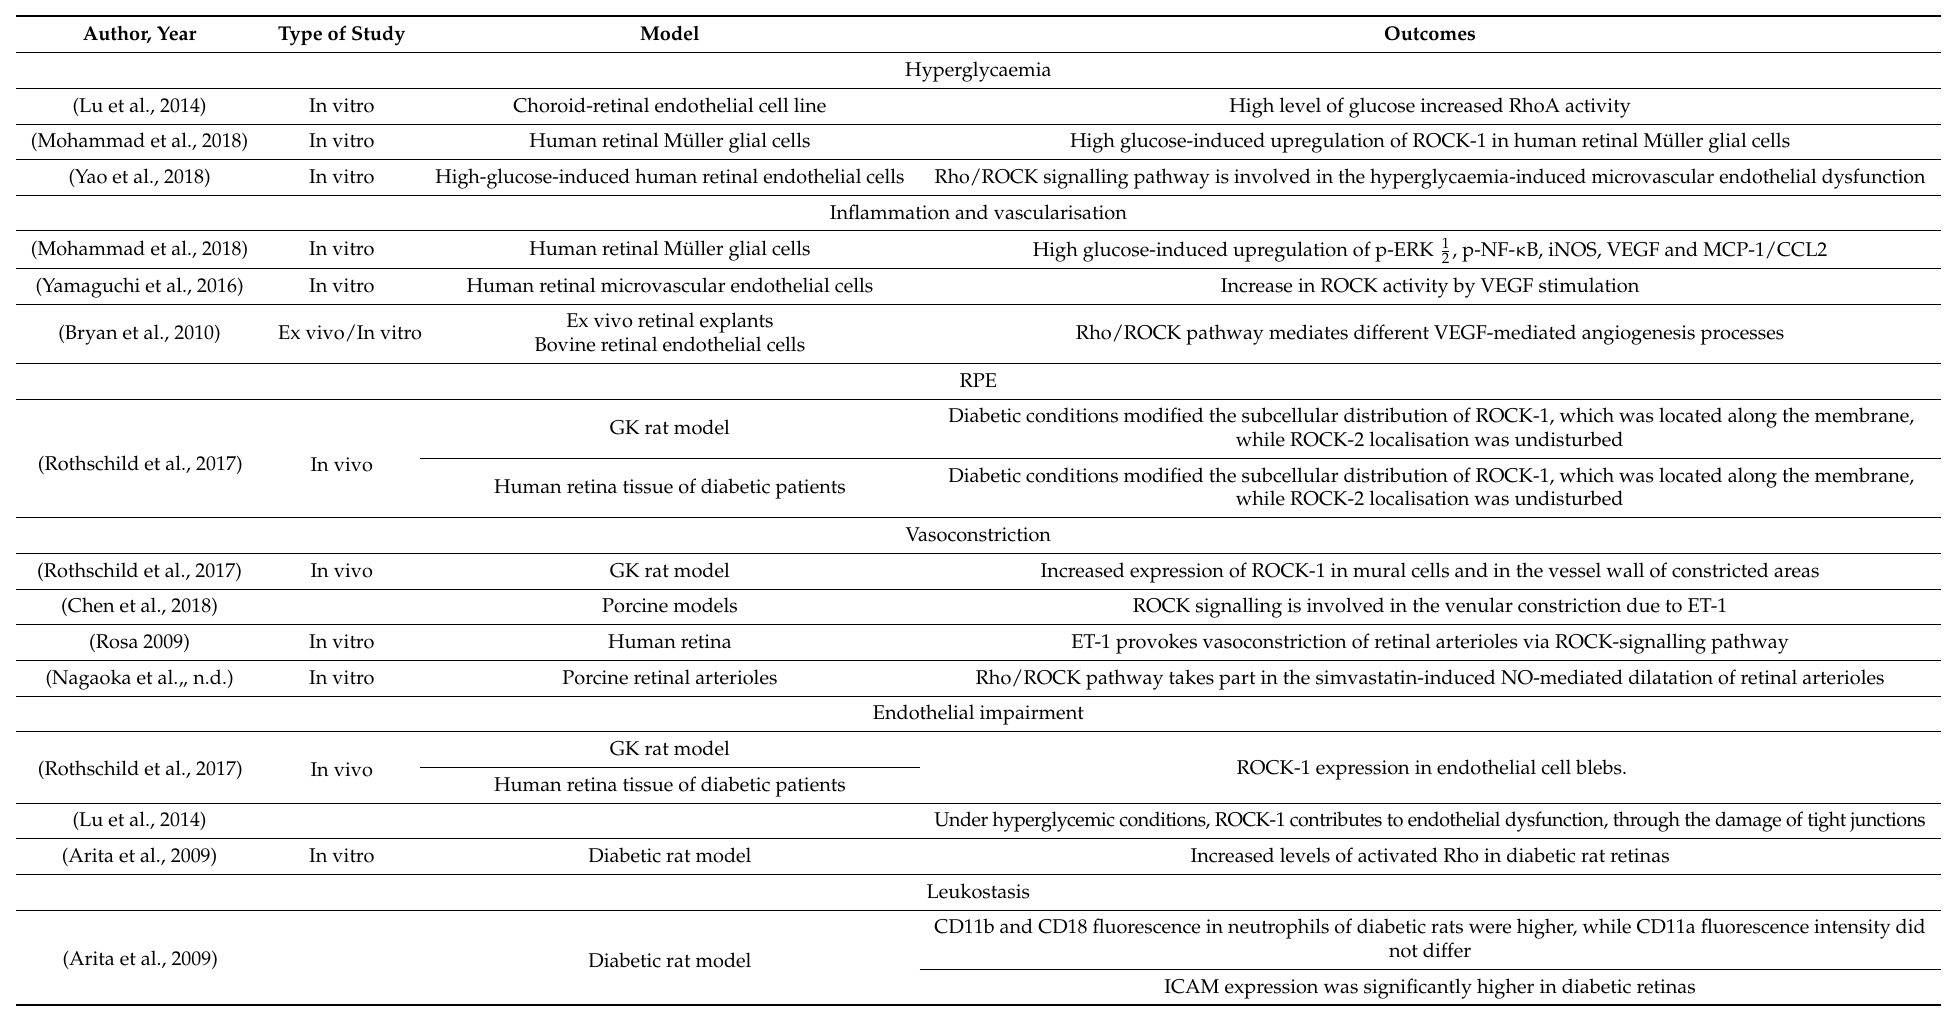
Table 1. ROCK signalling involvement in diabetic retinopathy